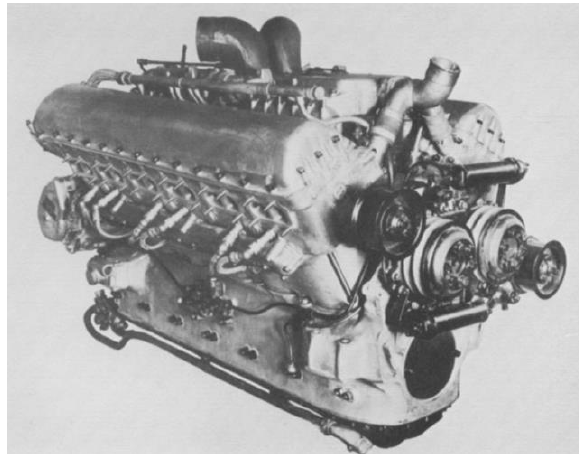
Fig. 5. The Rolls-Royce Meteor engine without any compressor